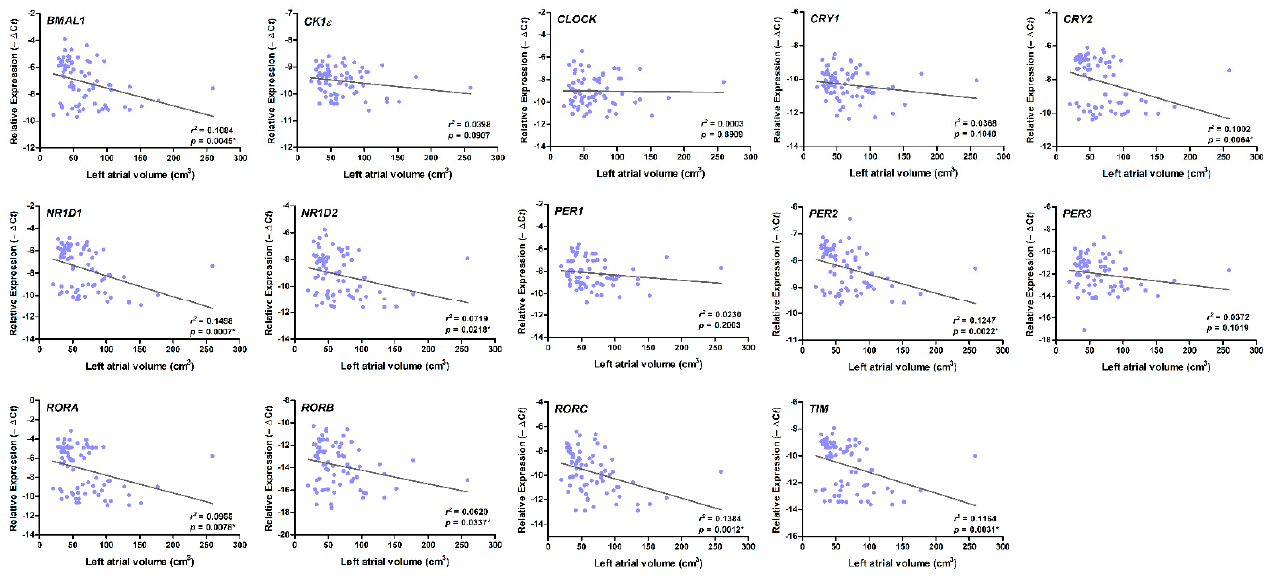
Table 2. Correlation between burden of atrial high-rate episodes (AHREs) and left atrial size, and correlation between AHRE burden and mRNA expression of circadian clock genes.